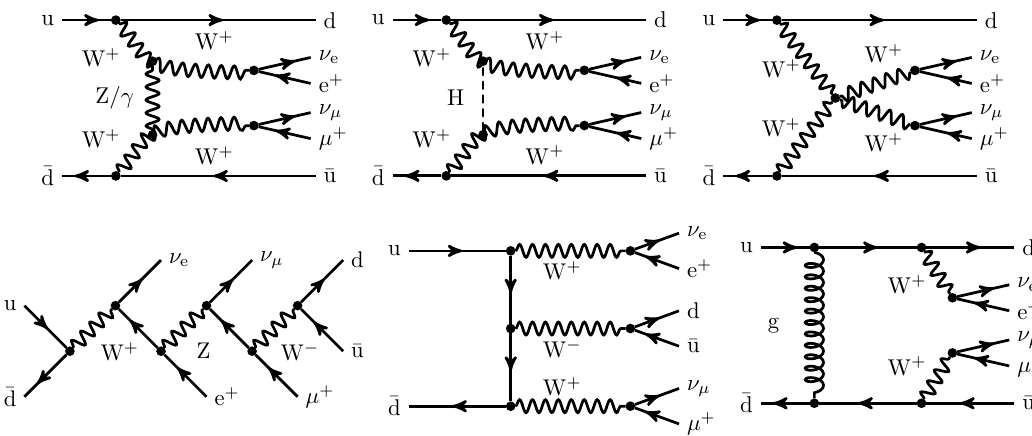
Figure 1. Sample tree-level diagrams that contribute to the process pp lead to a (cid:12)nal state with massive top quarks which falls under a di(cid:11)erent experimental